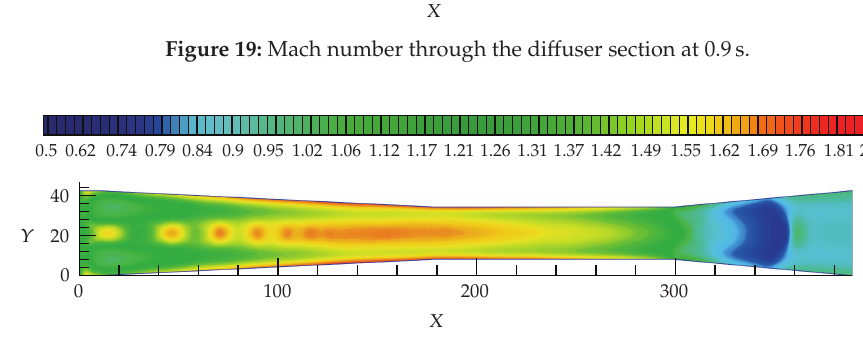
Figure 20: Density through the di ff user section at